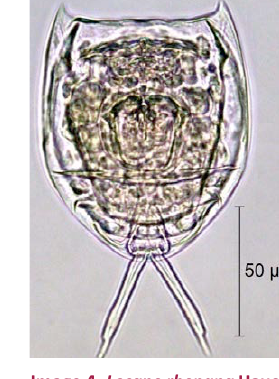
Image 4. Lecane rhenana Hauer (ventral view)